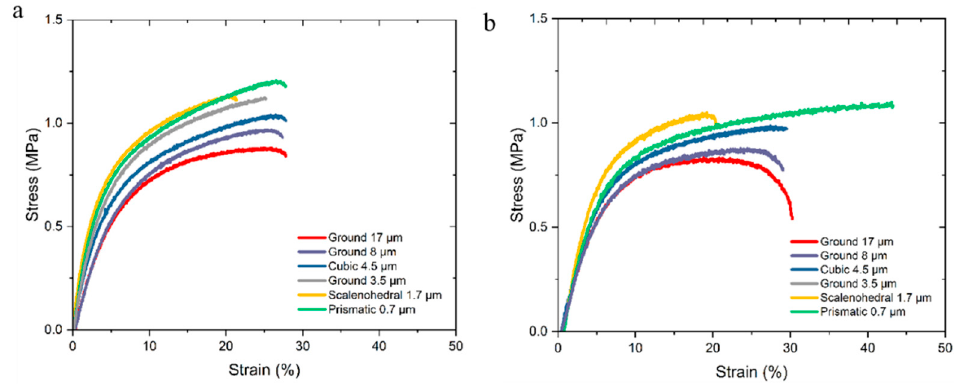
Figure 8. Composite tensile properties of injection-molded ( a ) and extruded ( b ) implant profiles .